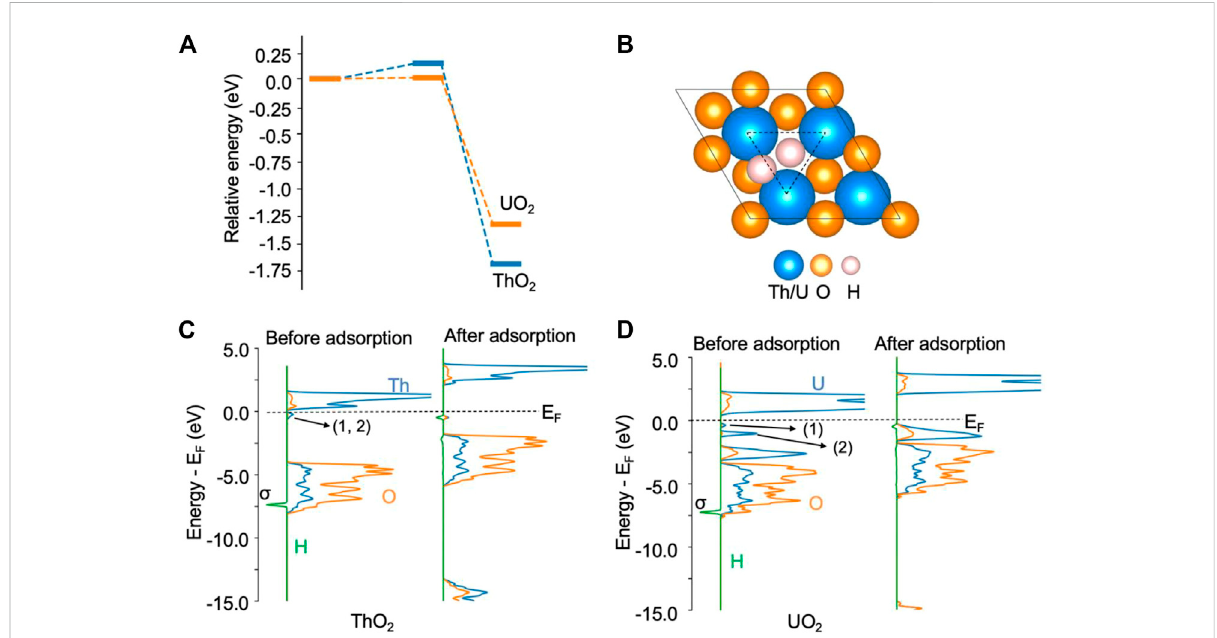
FIGURE 2 H 2 dissociationonThO 2 andUO 2 (111)surfacescontainingoxygenvacancies. (A) Adsorptionenergypro fi le.Thetotalenergyoftheinitialstateis set to zero. (B) Illustration of structures after H 2 adsorption. The oxygen vacancy site is highlighted by the triangle. (C) Density of states before and after H 2 adsorption on the ThO 2 surface. (D) Density of states before and after H 2 adsorption on the UO 2 surface. The two excess electrons on the ThO 2 surfacearelocatedatthevacancysiteslabeled1and2intheDOS,directlybelowtheFermilevel(E F )in (C) .OntheUO 2 surface (D) ,oneof the excess electrons (1) is located at a vacancy site and the other (2) in uranium 5 f